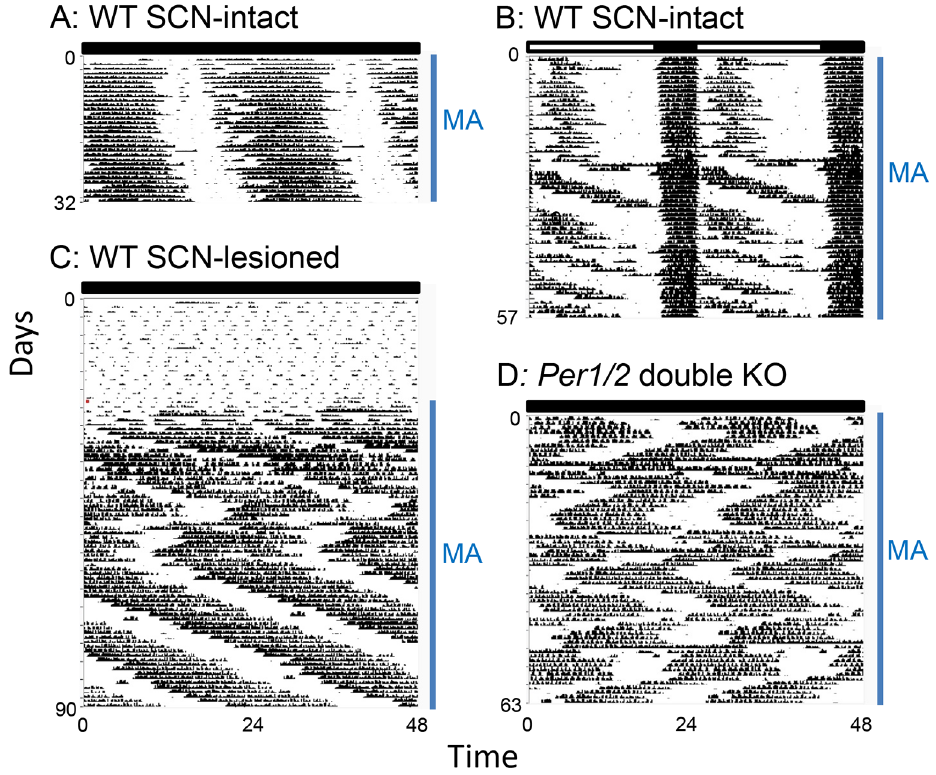
Figure3.ExamplesofMASCO-drivenactivityrhythmsinmice. A:Periodlengtheningoftheactivityrhythmduring short-term methamphetamine administration. The rhythm is controlled by coupled SCN and MASCO in wild-type mice in DD. B: Dissociation of SCN and MASCO-driven activity rhythms by methamphetamine administration in a